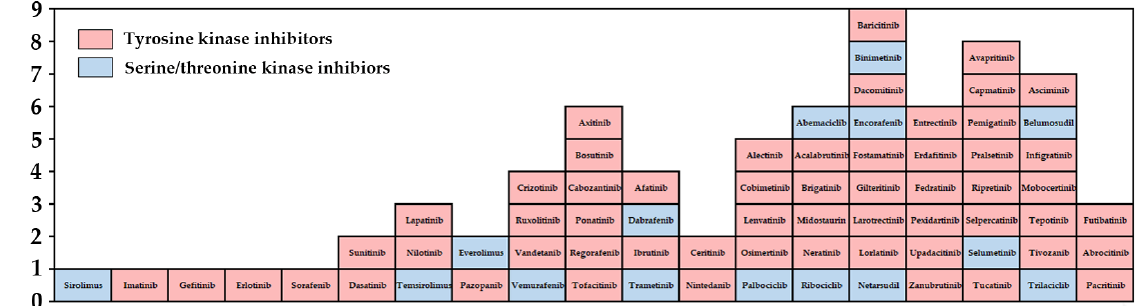
Figure 1. US Food and Drug Administration (FDA)-approved small molecular inhibitors that target kinases.